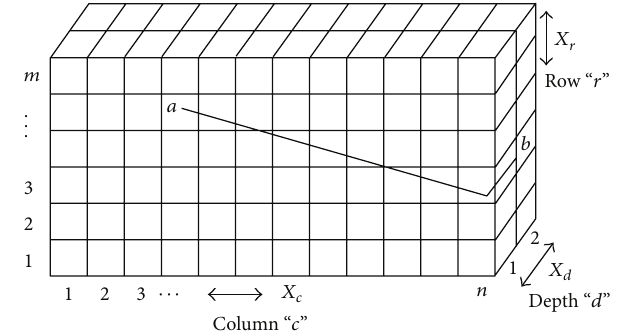
Figure 3: Description of the AS/RS structure